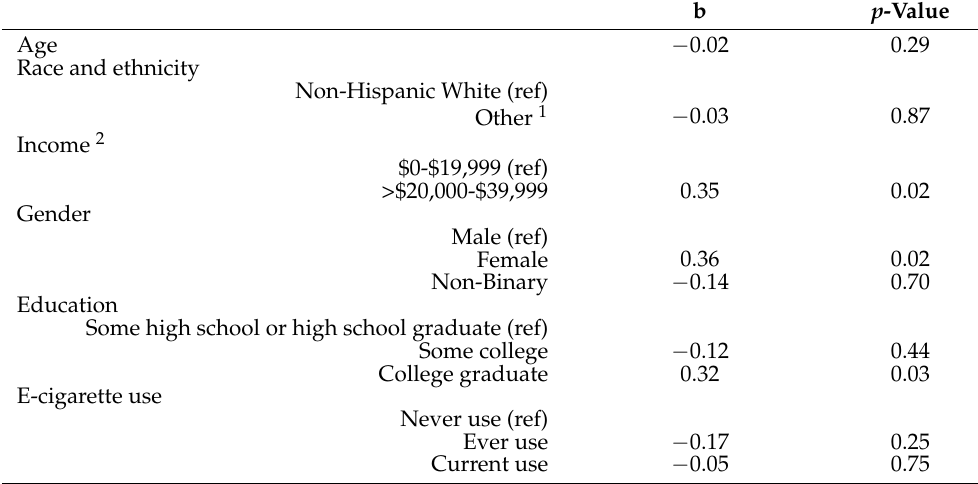
Table 2. Unadjusted associations of perceived source credibility and